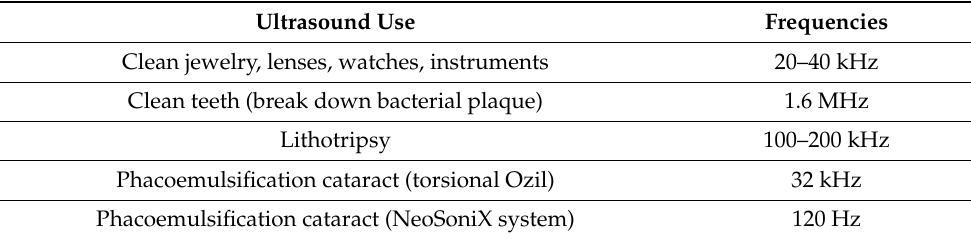
Table 5. Examples of the use of ultrasound and its frequencies. Ultrasound Use